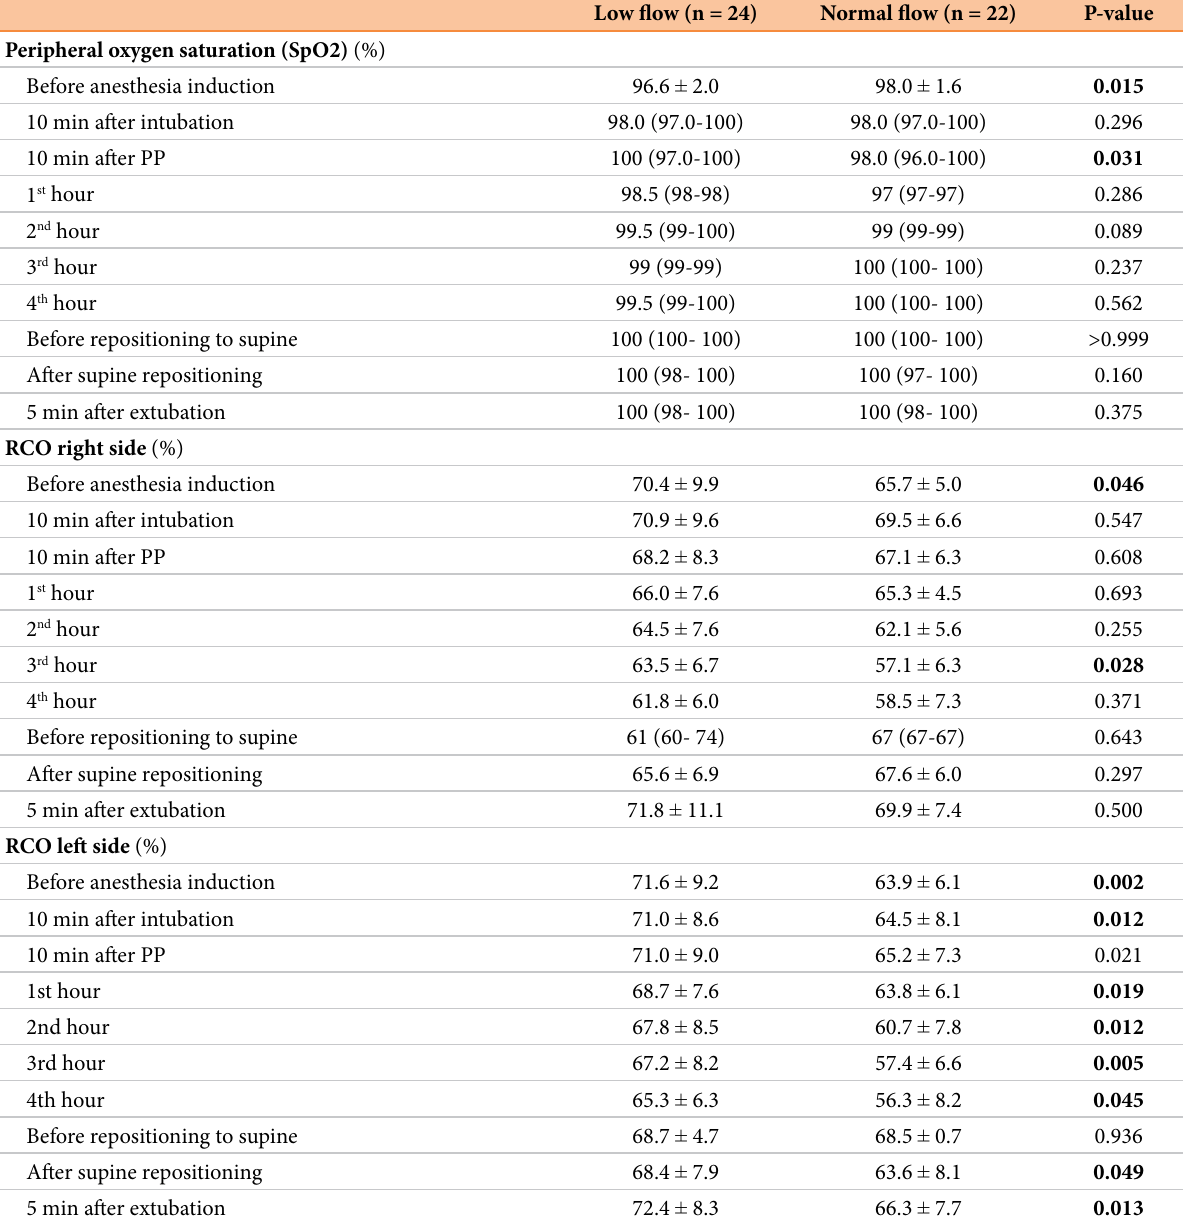
Table-3 – Comparison of peripheral oxygen saturation, and right and left side regional cerebral oxygenation during measurement time